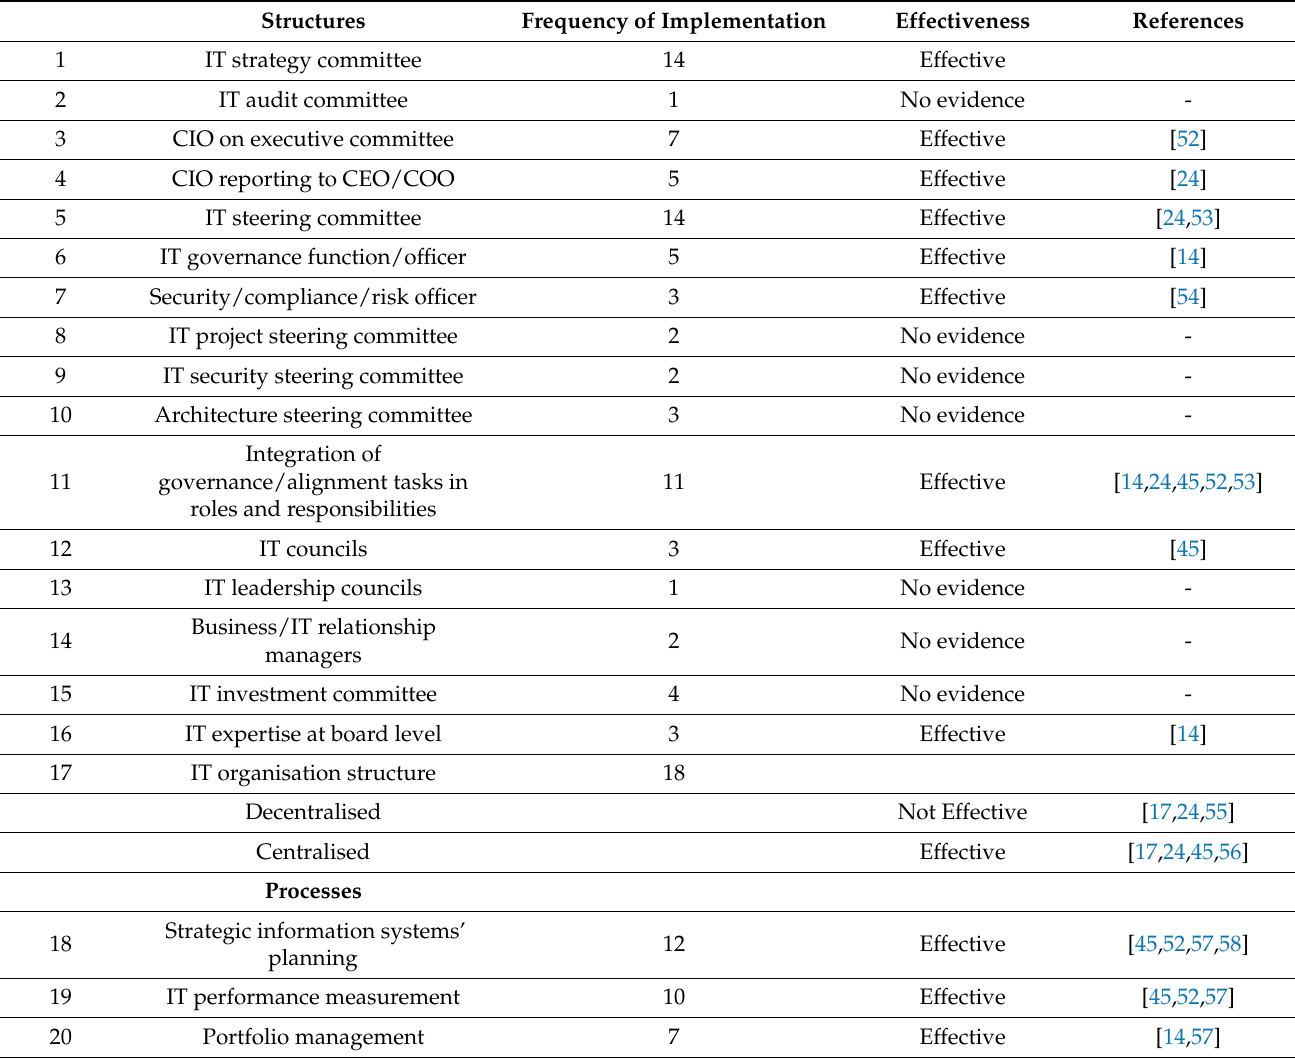
Table 1. Frequency of Implementation and